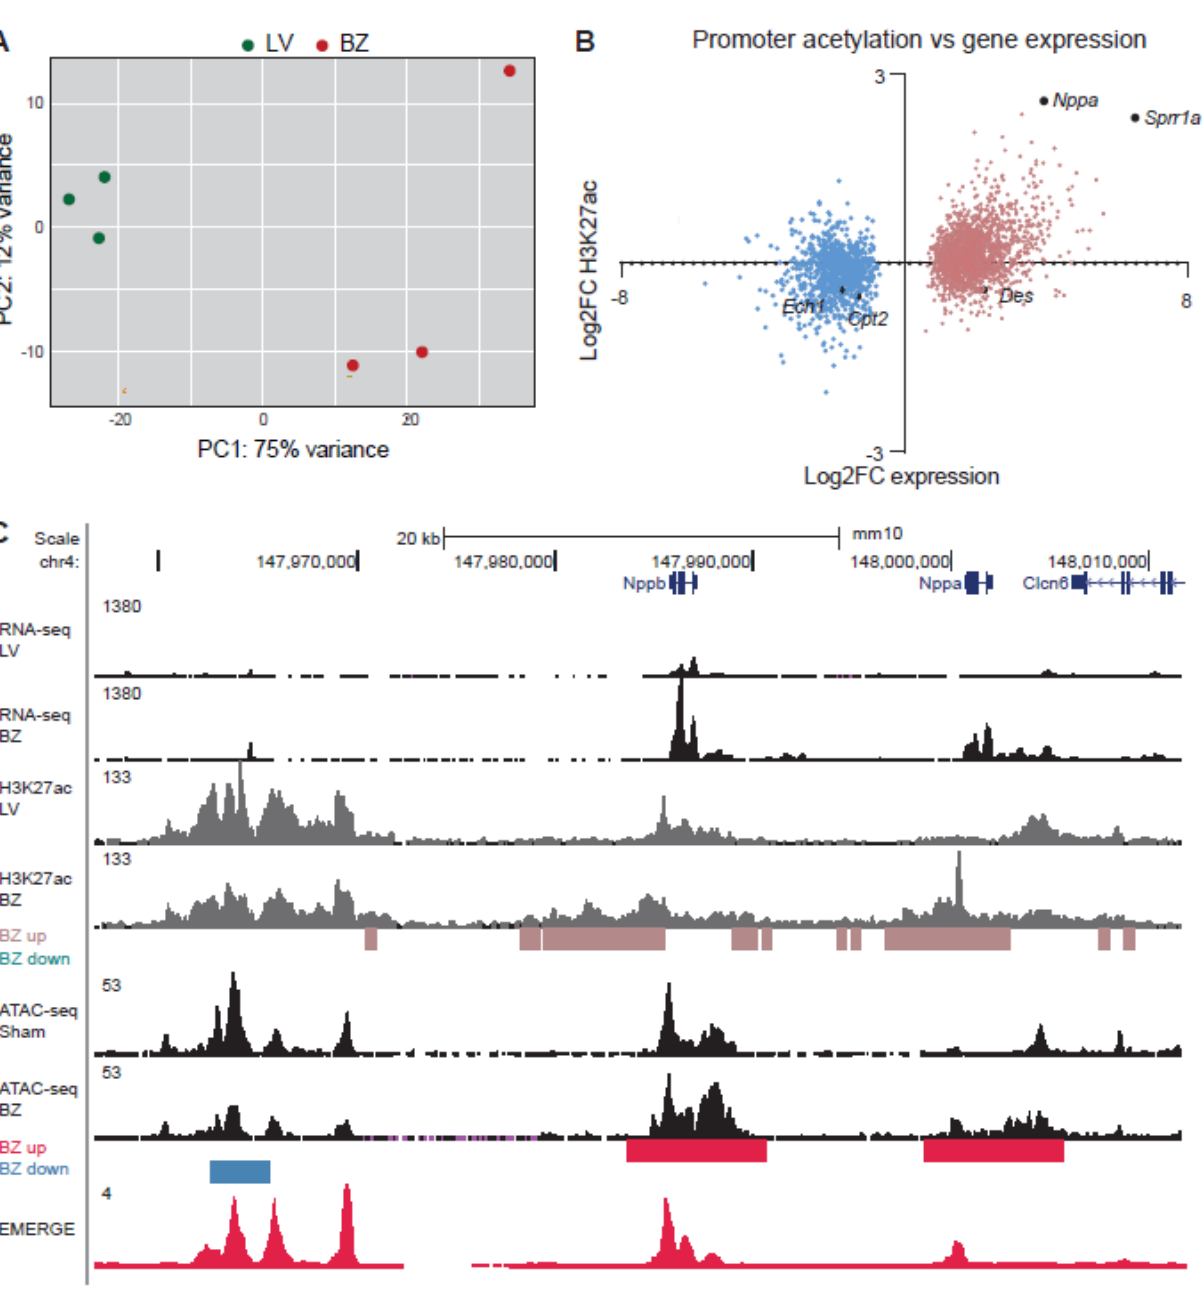
Figure 2. ( A ) Principal component analysis of samples from the left ventricle (LV) ( n = 3) and the border zone (BZ) ( n = 3) used for H3K27ac profiling by CUT&RUN-sequencing. ( B ) Scatterplot showing the relation between significantly differentially expression of genes between BZ and LV and differential acetylation of the transcription start site ( p value adjusted for multiple testing: false discovery rate <0.05). ( C ) Representative UCSC browser view showing the Nppa and Nppb locus. ATAC-seq, assay for transposase-accessible chromatin using sequencing; CUT&RUN-seq, cleavage under target and release using nuclease -sequencing.